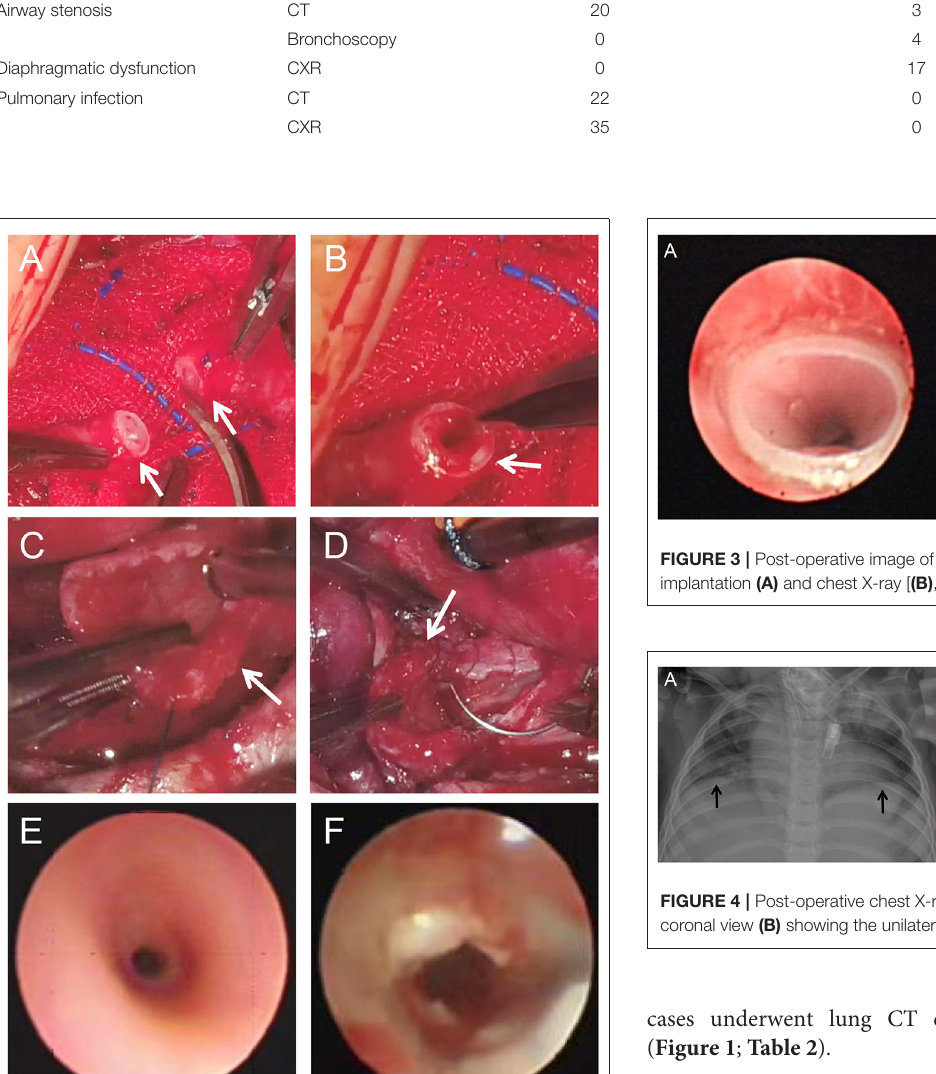
cases underwent lung CT examination before the surgery ( Figure 1 ; Table 2